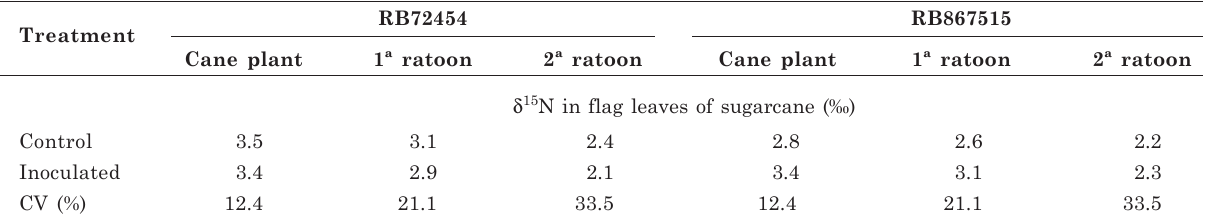
Table 3. Delta ( δδδδδ 15 ) in the sugarcane flag-leaf inoculated with diazotrophic bacteria and in the uninoculated control grown for three consecutive harvests on an Albaquult on an experimental field of Embrapa Agrobiologia, Rio de